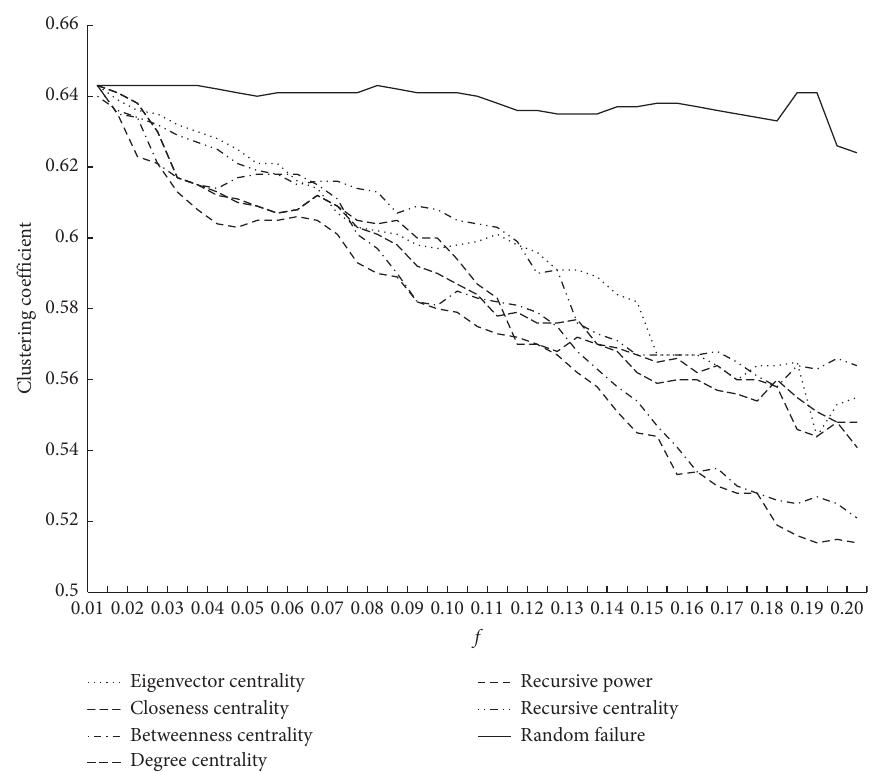
Figure 5: Evolution of the clustering coefficients in unweighted and weighted networks. f refers to the percentage of nodes removed.